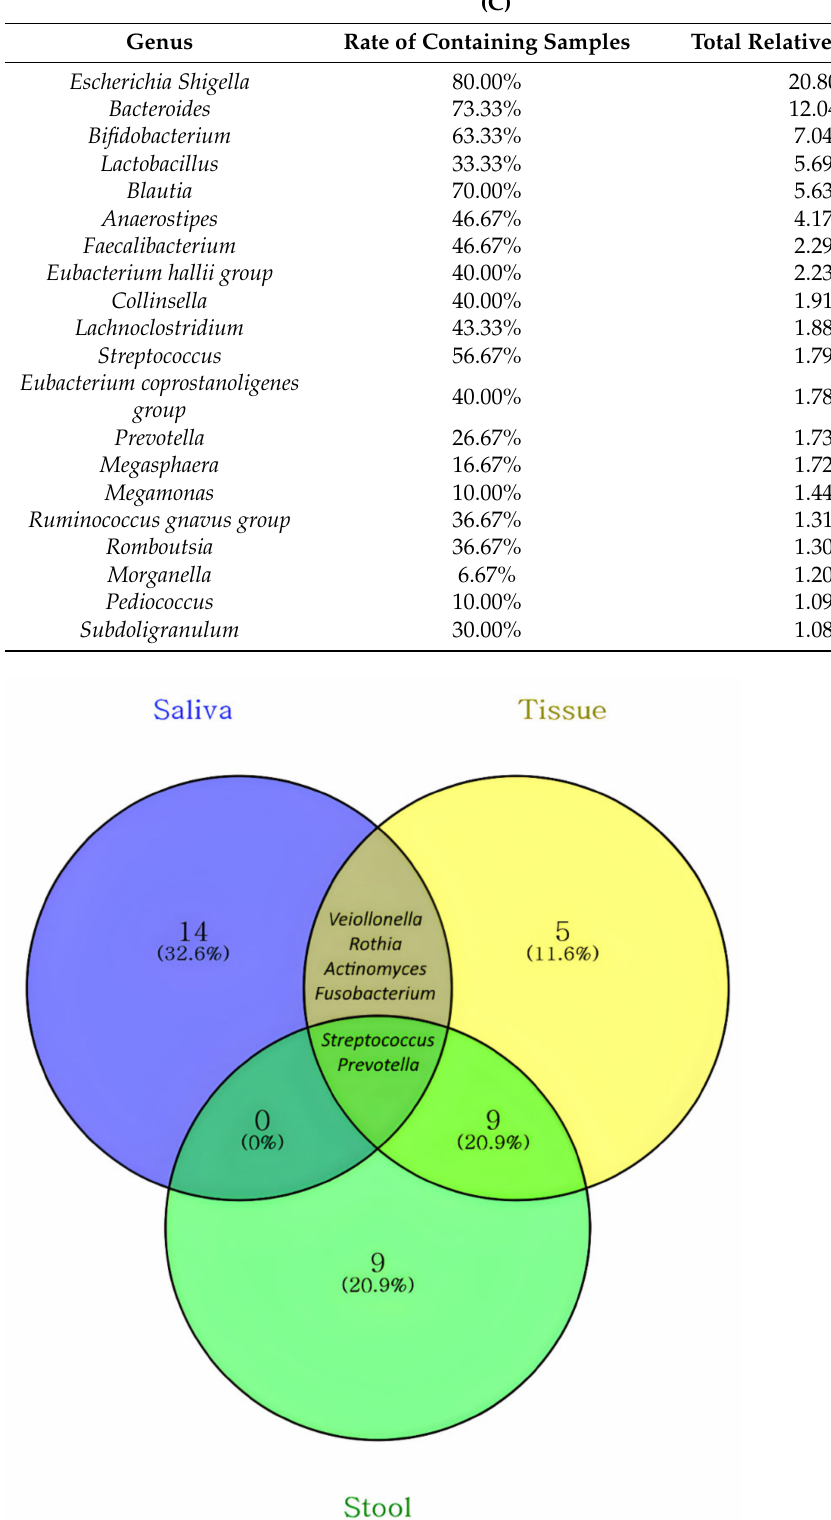
Figure 5. Venn diagram of top twenty abundant genera in the microbiome in the saliva, tissue, and stool samples of patients with CD. Prevotella and Streptococcus were common among the three sample